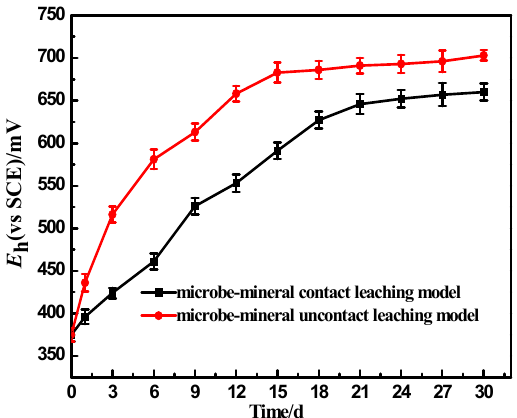
Figure 2. pH changes with bioleaching time.